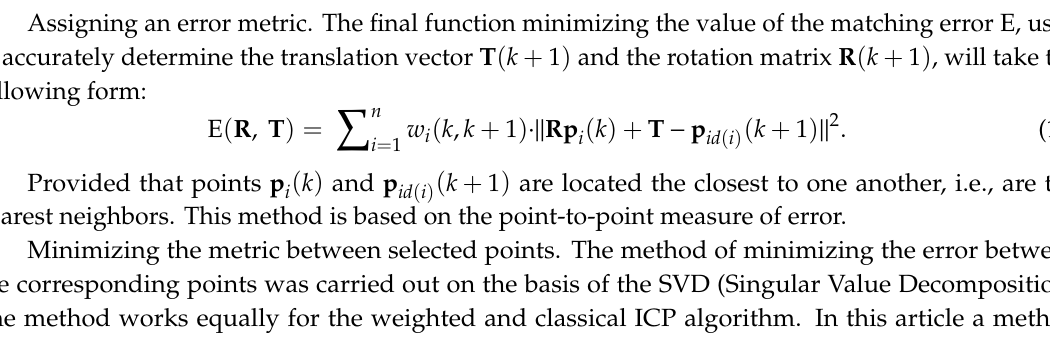
Figure 5. Rejecting pairs due to robust criterion.